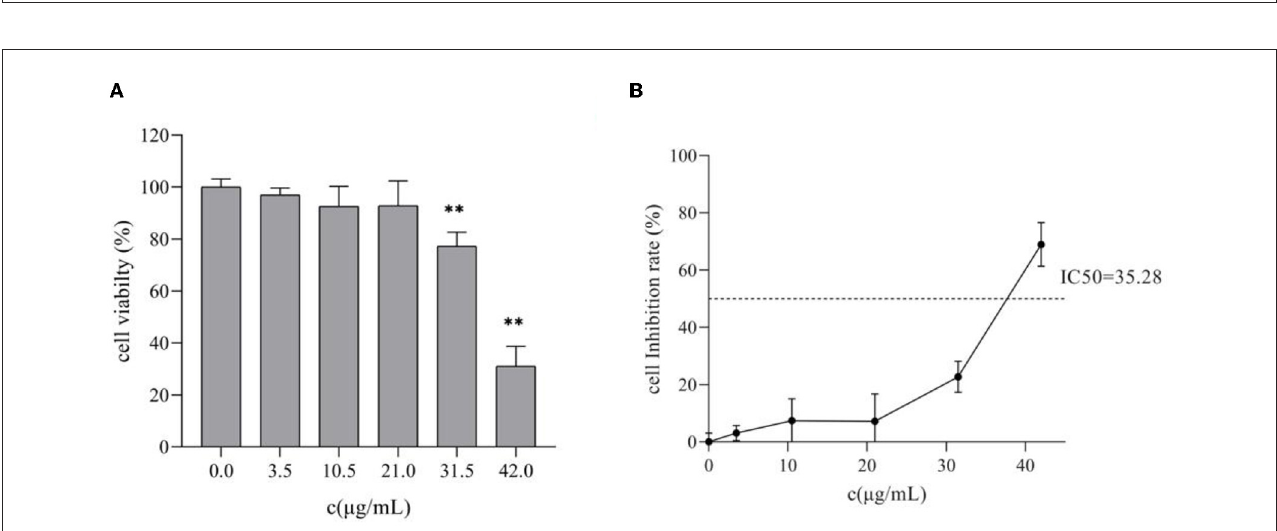
FIGURE2 Effects of different concentrations of TG on the proliferation of HepG2 cells. (A) The survival rate of HepG2 cells. (B) The inhibition rate of HepG2 cells; IC 50 represents the 50% inhibition of cell viability. ** P < 0.01.